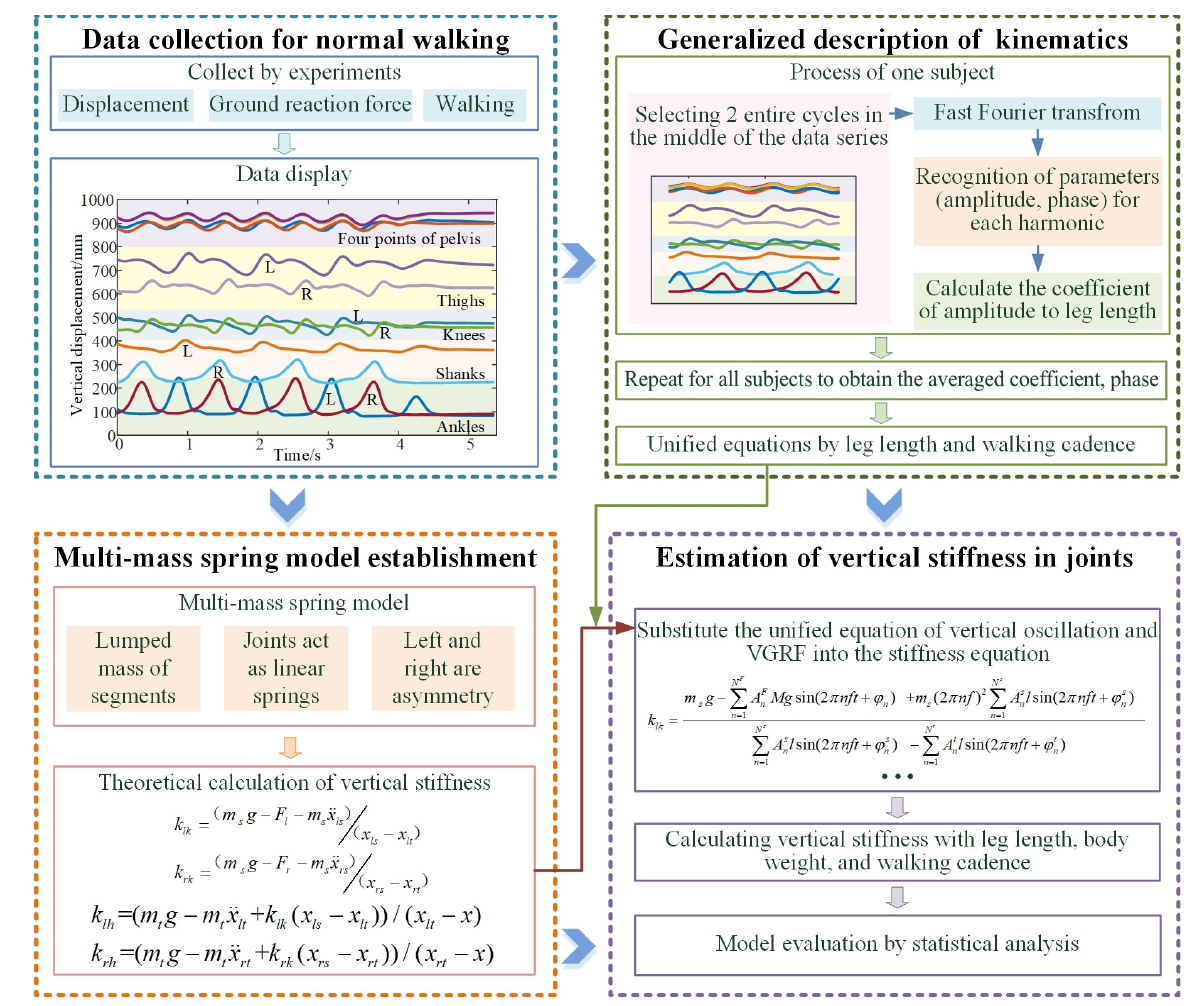
Figure 1. The process of the estimation of vertical stiffness by a dynamic model.